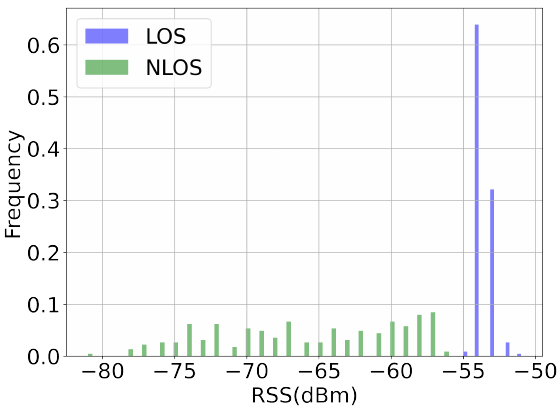
Figure 8. The WiFi RSS signal measure under different scenarios. A smartphone was placed 3 m away from the access point. We observed that in NLOS experiment where the signal was blocked by human body, the RSS measurement became unstable and reduced drastically due to the NLOS